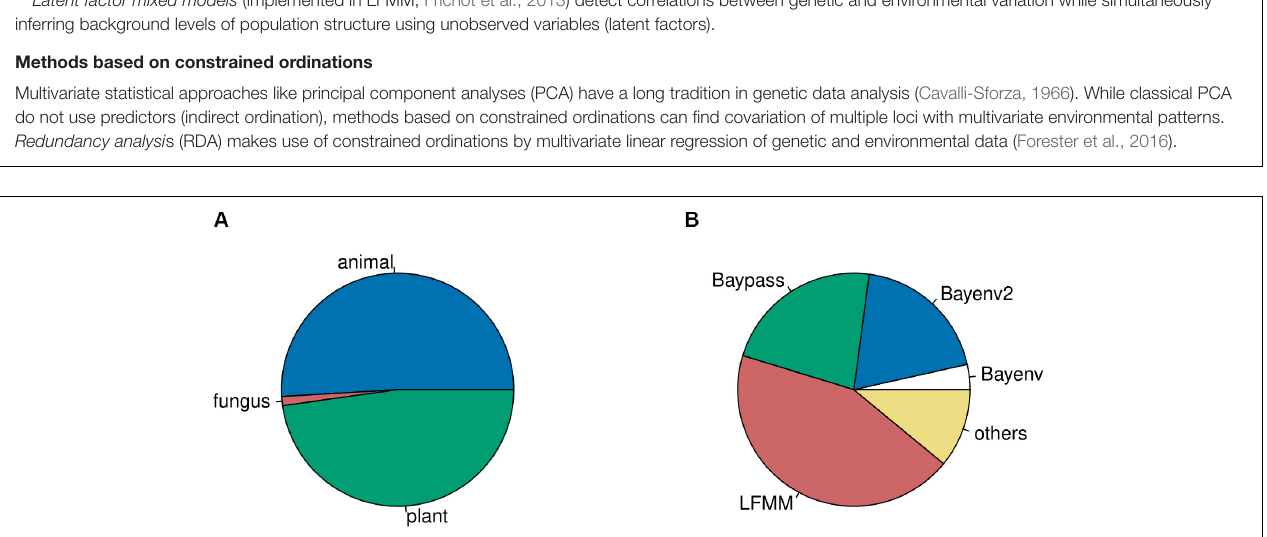
FIGURE 2 | The fraction of studies based on animals and plants is almost equal (A) . Frequency of tools used in GEA studies (B) . Tools which were used in less than four studies are summarized under “others”: RDA, AutoLM, GEMMA, GLMM, Lositan, MLM, partial Mantel test, Moran spectral randomization, Sam β ada, Selestim, and